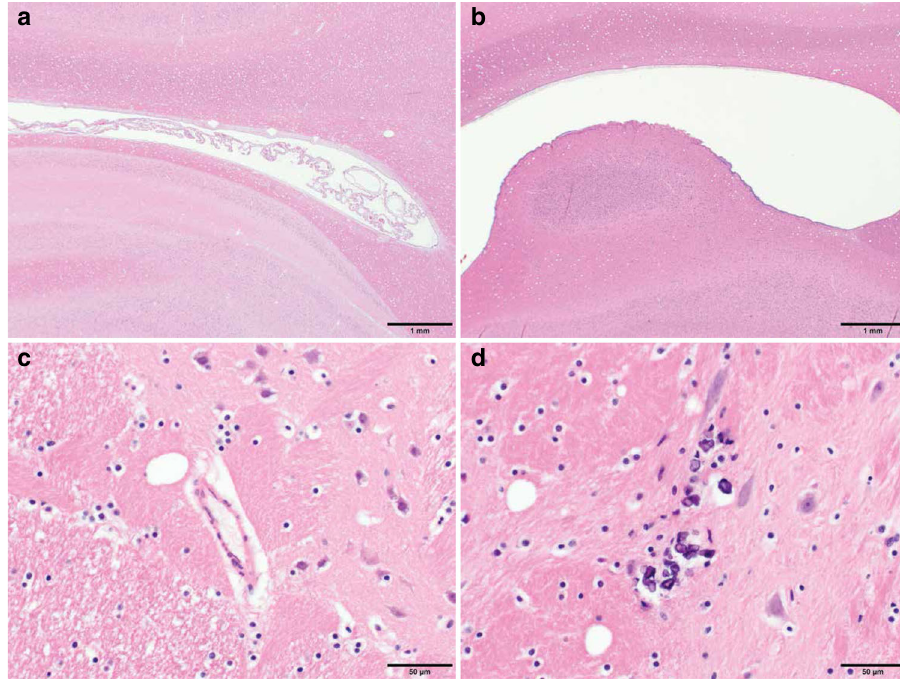
Fig. 5 Neurohistopathology at 12 months of age after postnatal ZIKV infection of infant RMs. a Hematoxylin and eosin (H&E) staining of occipital cortex of control animal, ×20 magni fi cation; b H&E staining showing distention of lateral ventricle in a occipital cortex of ZIKV-infected RM, ×20 magni fi cation; c H&E staining of basal ganglia (putamen) of control animal, ×400 magni fi cation; d areas of neuropil calci fi cation (arrowhead), H&E staining, ×400 magni fi